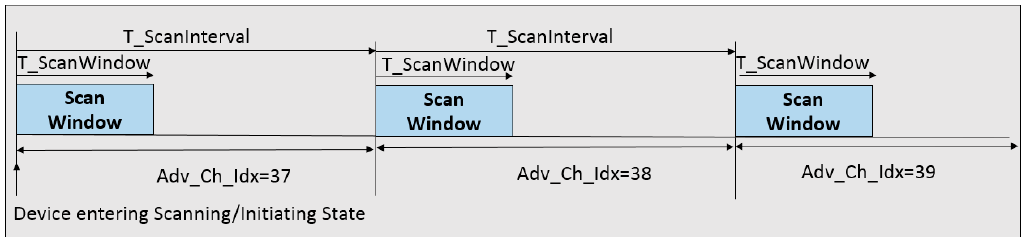
Figure 2. Timing specification for scanning event.